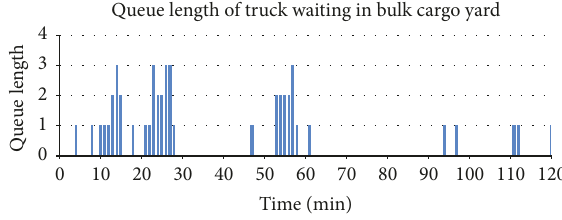
Figure 15: Queue length of trucks in bulk cargo